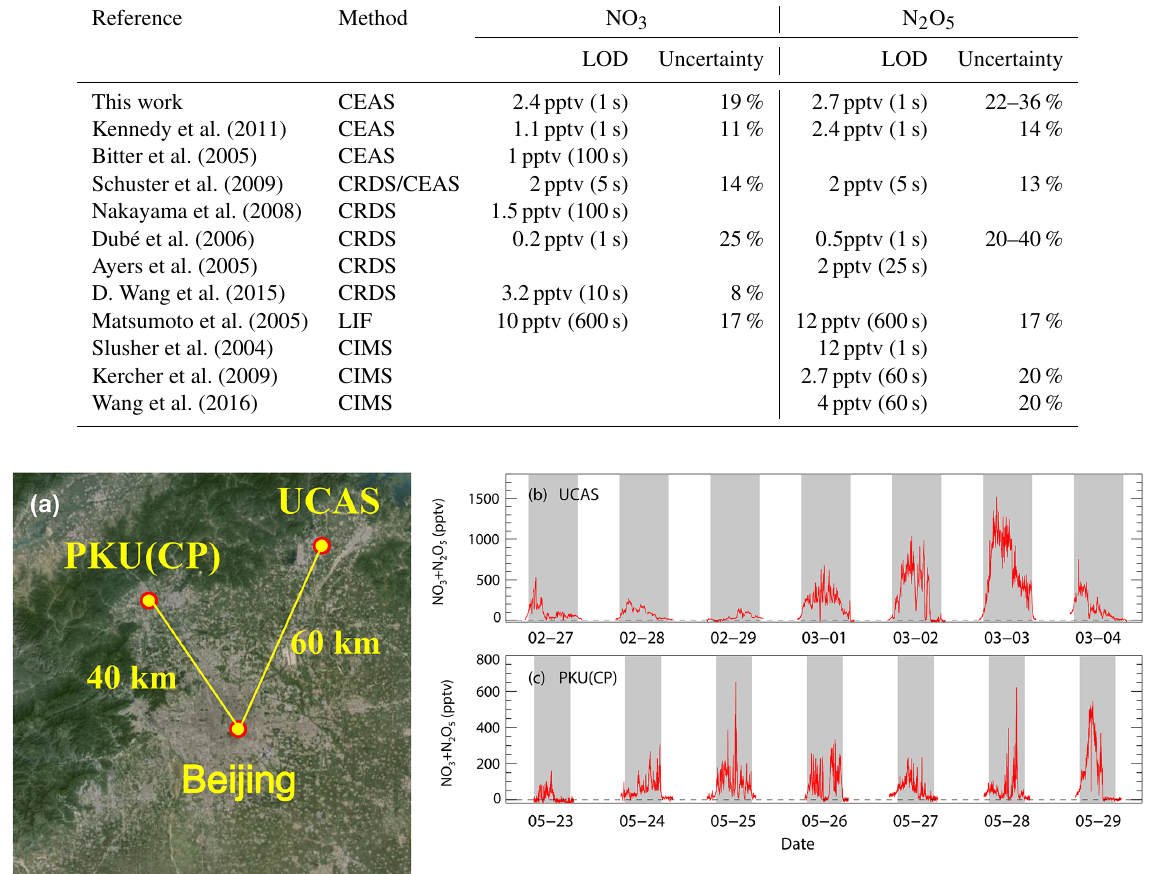
Figure 10. Two example time series of the observed mixing ratios of NO 3 + N 2 O 5 measured during the UCAS winter campaign 2016 and the PKU(CP) summer campaign. The grey box indicates the time span for night-time. Panel (a) depicts the map of the two sites, indicating the UCAS site and the PKU(CP) site, that are about 60 and 40km away from the centre of Beijing, respectively. Panel (b) shows a typical development of the observed mixing ratio of NO 3 + N 2 O 5 from clean to polluted air masses at UCAS. Panel (c) shows the observed mixing ratio of NO 3 + N 2 O 5 during a typical pollution episode at